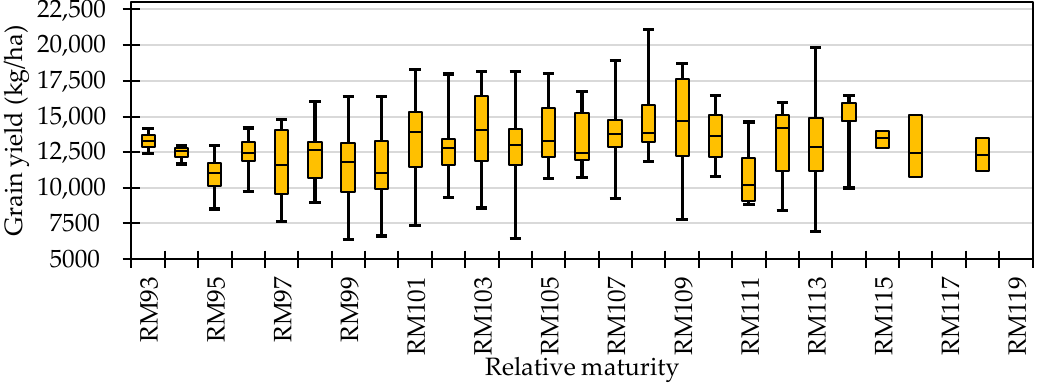
Figure4. Figure 4. Box plots of maize grain yield as function of the relative maturity (RM) for the 2003 – 2019 period.